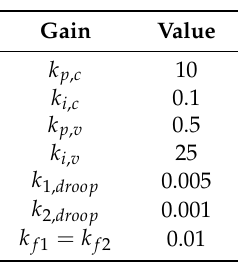
Table 2. Controllers’